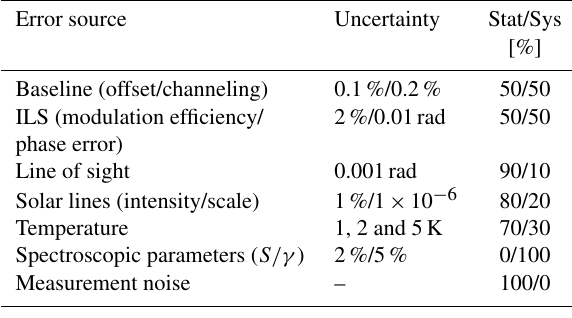
Table 2. Error sources used in the error estimation, the second col- umn gives the uncertainty used and the third the statistical (Stat) and systematic (Sys) contributions of each source in percentage.